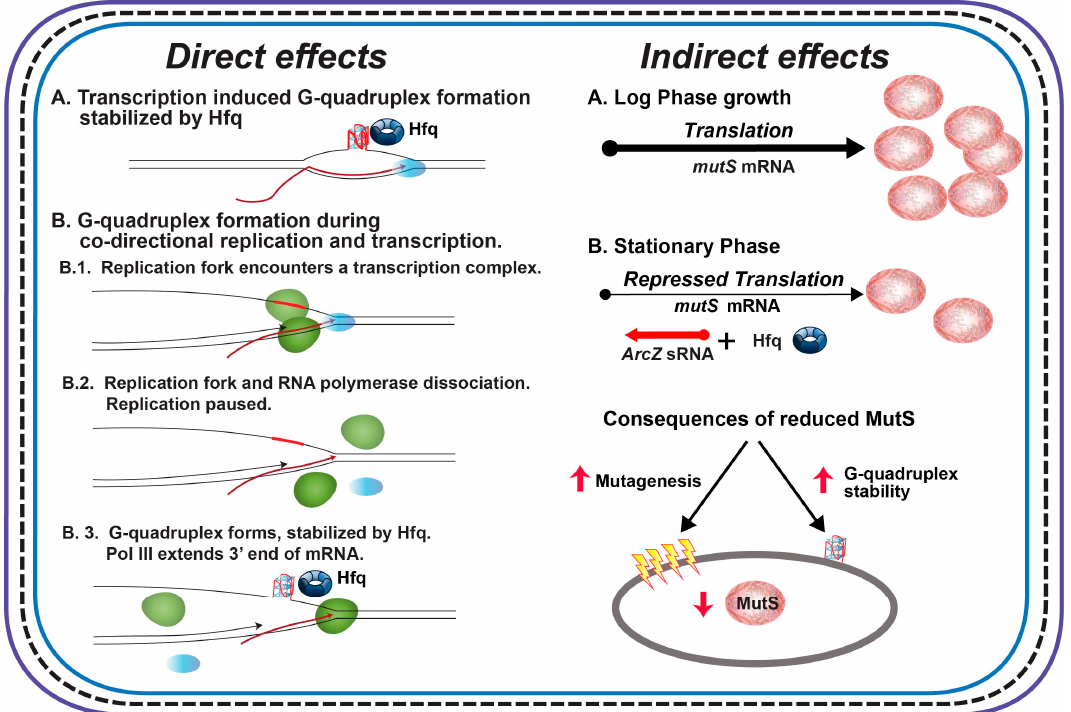
Figure 4. Model of direct and indirect effects of Hfq on genome instability. Description of the figure is included in the text. Direct effects: Green ovals represent DNA Pol III; blue ovals, RNA polymerase. Hfq is represented by the donut. Indirect effects: MutS is represented by the brown ovals. Red arrows represent increased or decreased levels.